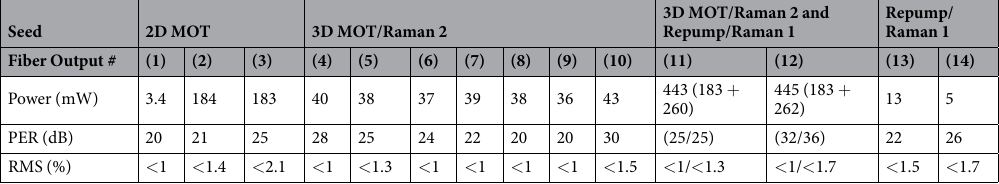
Table 1. Mean output power (mW), PER (dB) over three hours, and the RMS power stability over 70 hours of the 14 fiber outputs of the system. Fiber numbering matches the output labels in Fig. 2. The mean output power is measured for maximum RF input power to the AOM and typical EDFA parameters. Fibers (1) to (3) are for the 2D MOT. Fibers (4) to (9) are for the 3D MOT. Fiber (10) is for detection and clearing the F = 2 manifold. Fiber (11) and (12) are for the Raman transitions required for state and velocity selection; the power from the amplifiers is separately shown as are the PERs. Fiber (13) is for clearing the F = 1 manifold. Fiber (14) is for detection of atoms in the F = 1 manifold. Not accounted for here, there is an additional fiber, labeled “3D MOT repump” in Fig. 2, which provides 19 mW of repump light distributed among (7), (8), and (9); the PER of this fiber is 21